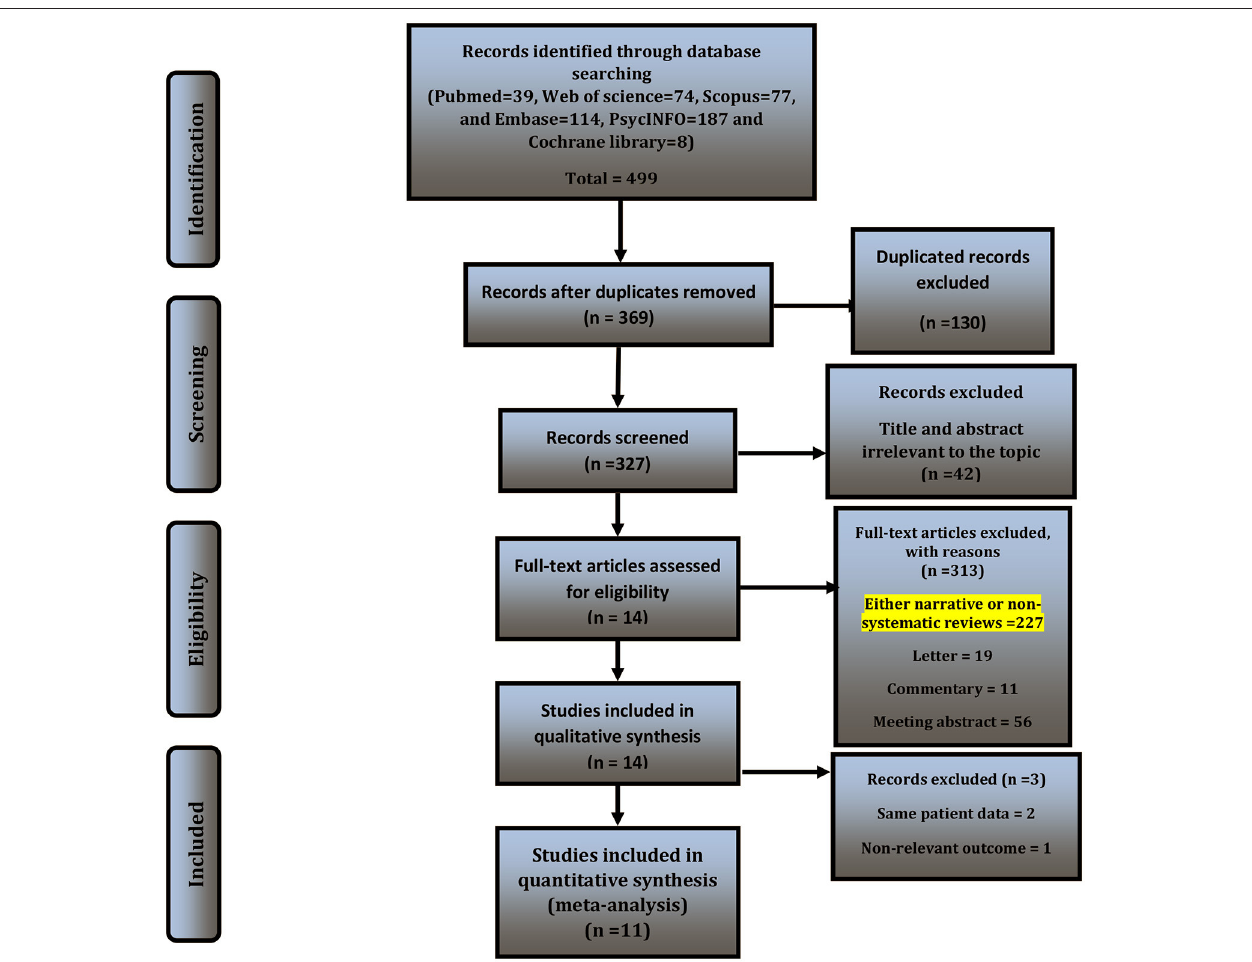
FIGURE 1 | PRISMA flowchart of the study selection